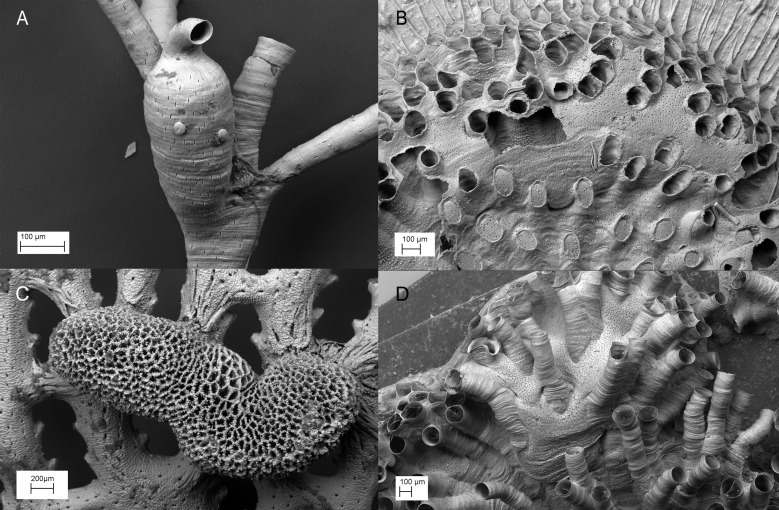
Images of exemplar of cyclostome bryozoan incubation chambers (gonozooids) from scanning electron microscopy.(A) Filicrisia geniculata, (B) Plagioecia patina, (C) Hornera robusta and (D) Tubulipora plumosa.